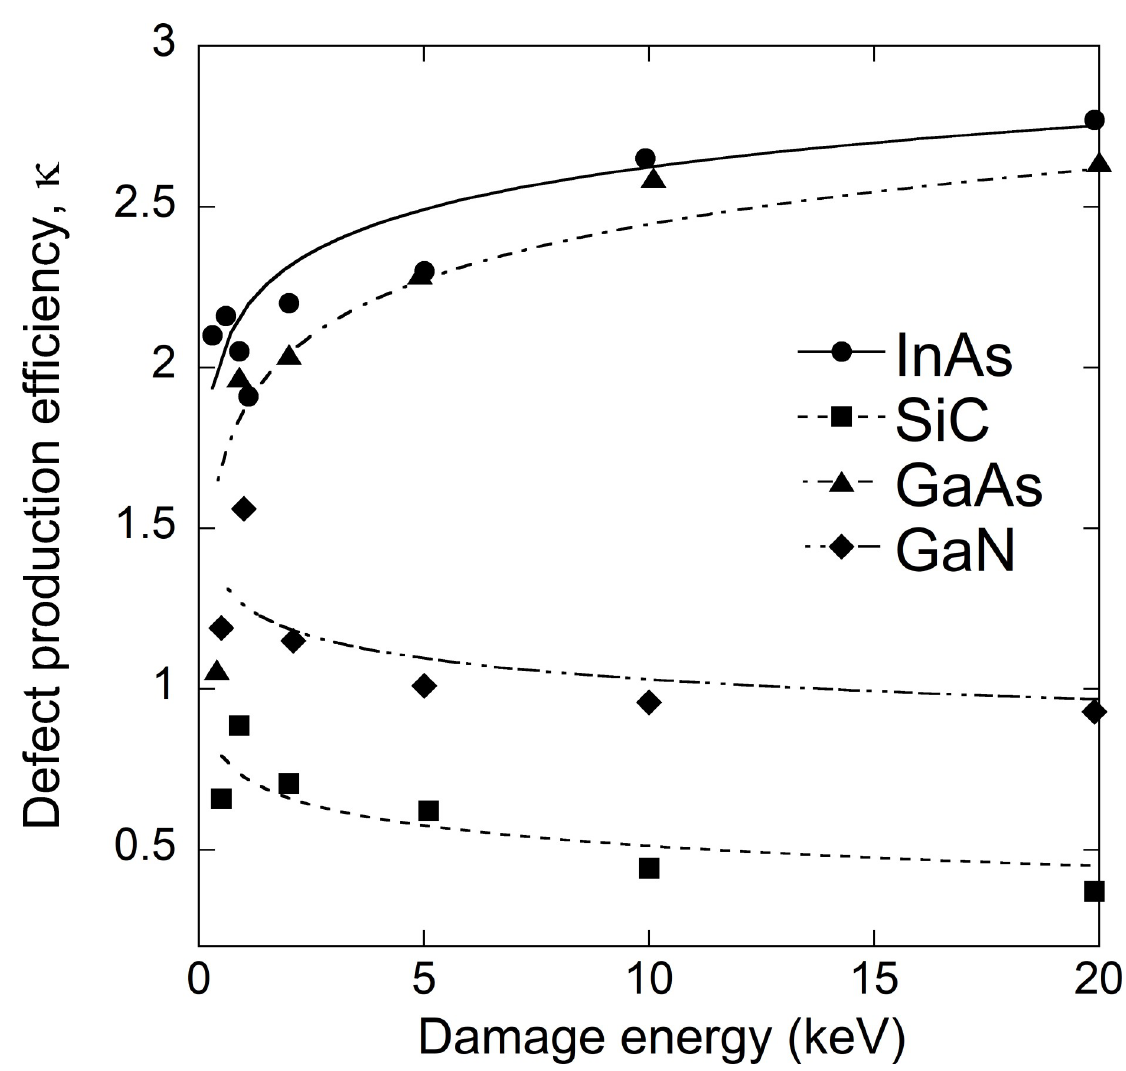
Fig 2. Defect production efficiencies as functions of the cascade damage energy for SiC, GaAs, GaN and InAs. The surviving probabilities of defects for the arsenic compounds GaAs and InAs evidently increase along with the damage energy and this increase is nonlinear over the energy range from 1 to 20 keV.